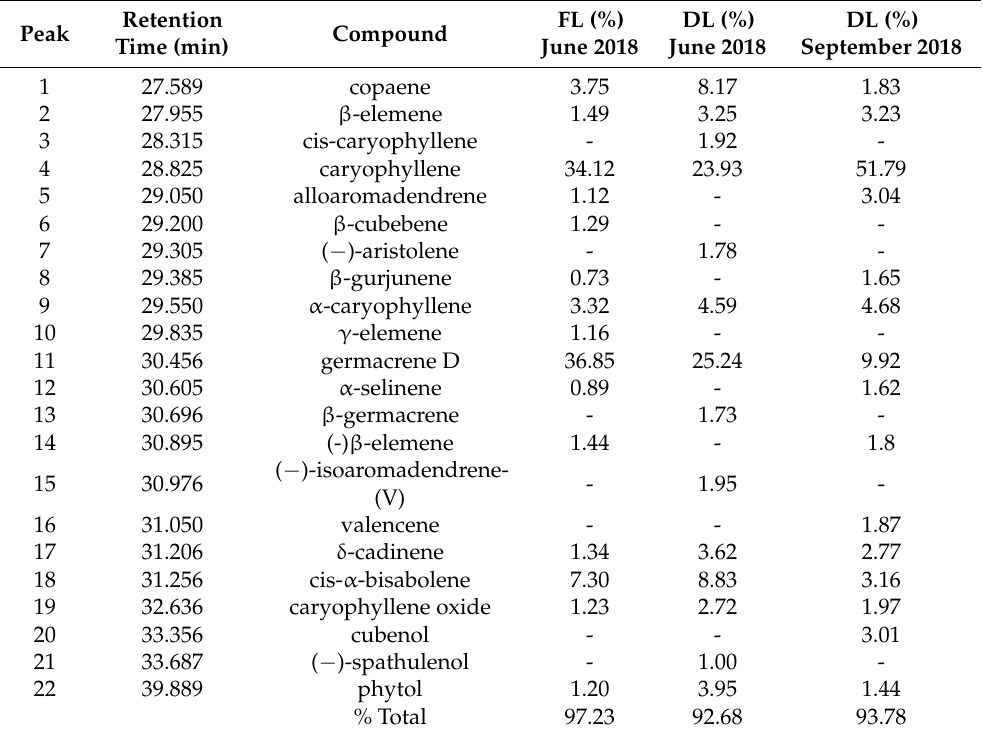
Table 2. Compounds ( ≥ 1%) were extracted by hydrodistillation from the fresh (FL) and dehydrated (DL) leaves of Cedrela odorata